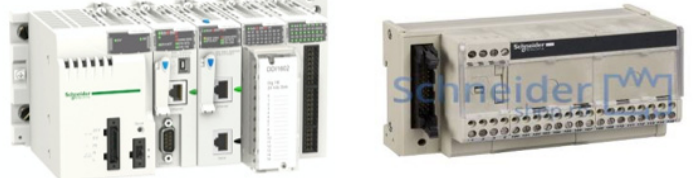
Figure 2. Schneider Electric programmable automaton [36].